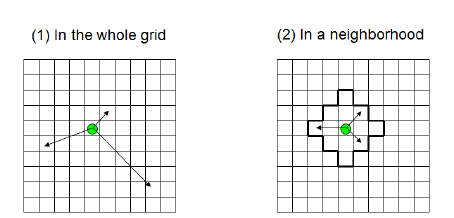
Figure 3. Two type of deplacement of agent in an environment that the number of recov ered individ uals giv en by the EBM model is exactl y the expectancy of the number of recov ered individ uals giv en by the ABM model (provided that there is no infection occurring at the same time). Stochasticity of recov ery rate appears at